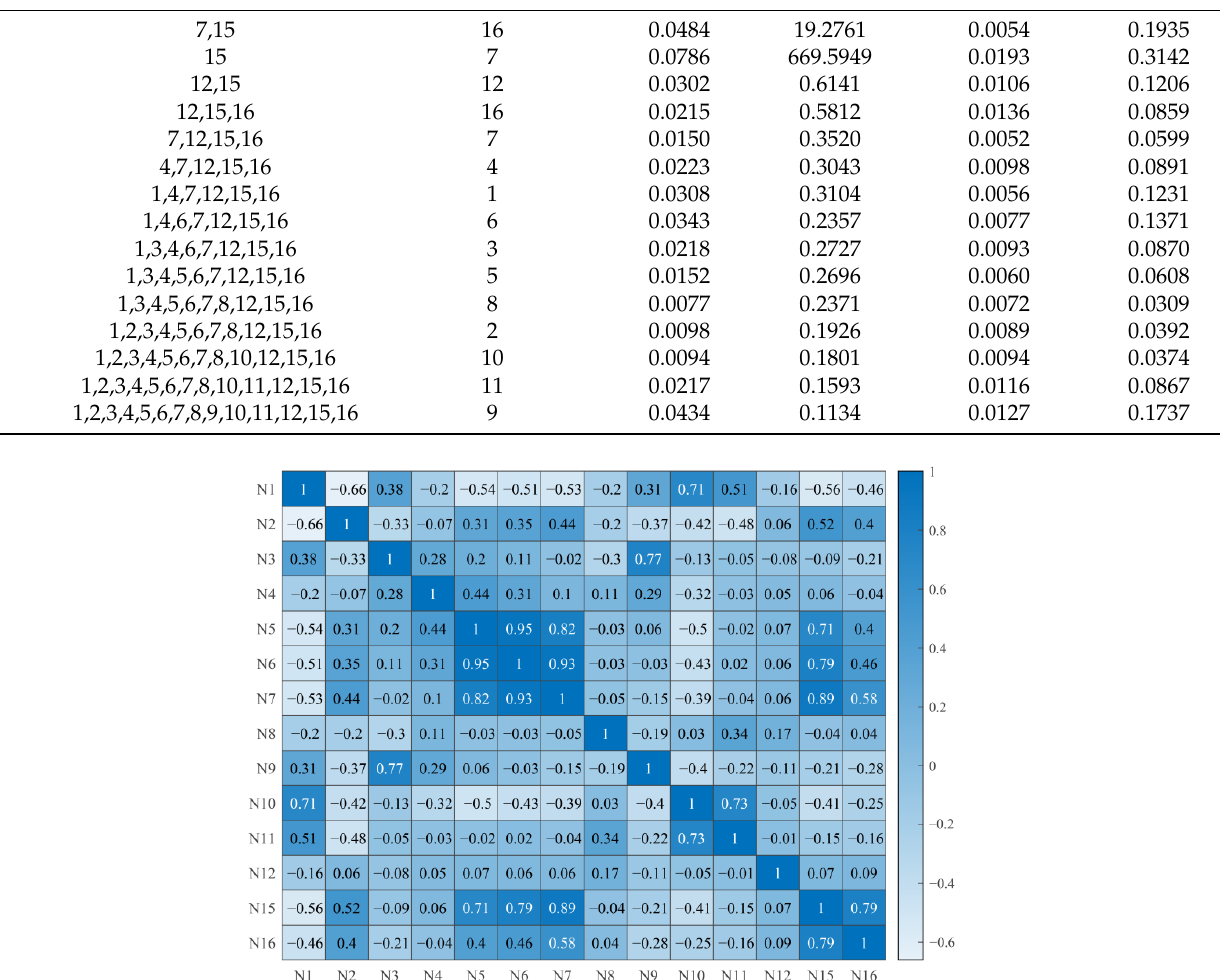
Figure 4. Heatmap of the variable correlations in the temporal dimension.